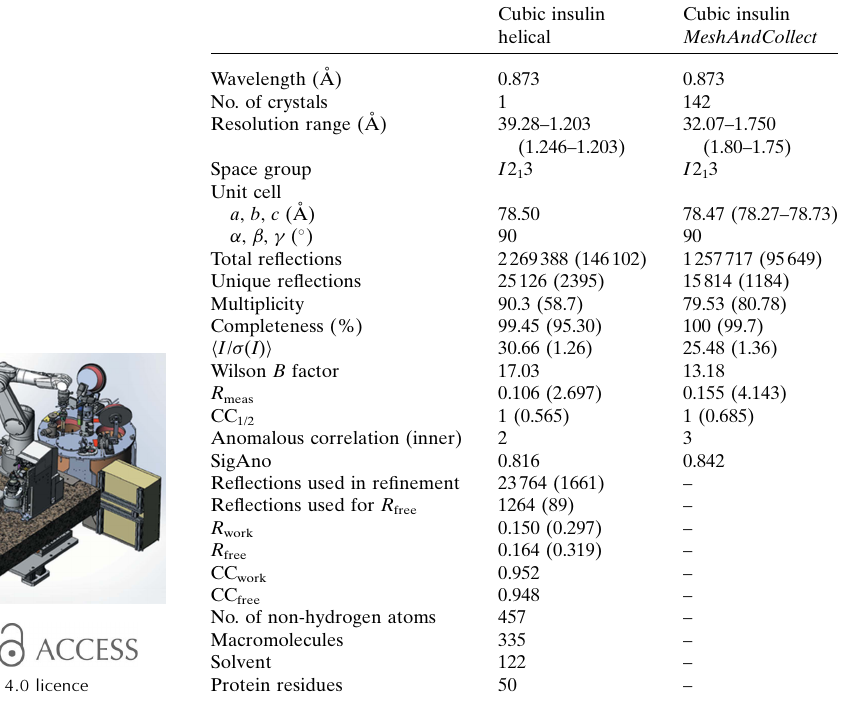
Table 2 Data collection and refinement statistics. Statistics for the highest-resolution shell are shown in parentheses. For the MeshAndCollect data, the average cell edge and range are provided. A refinement was not performed for these